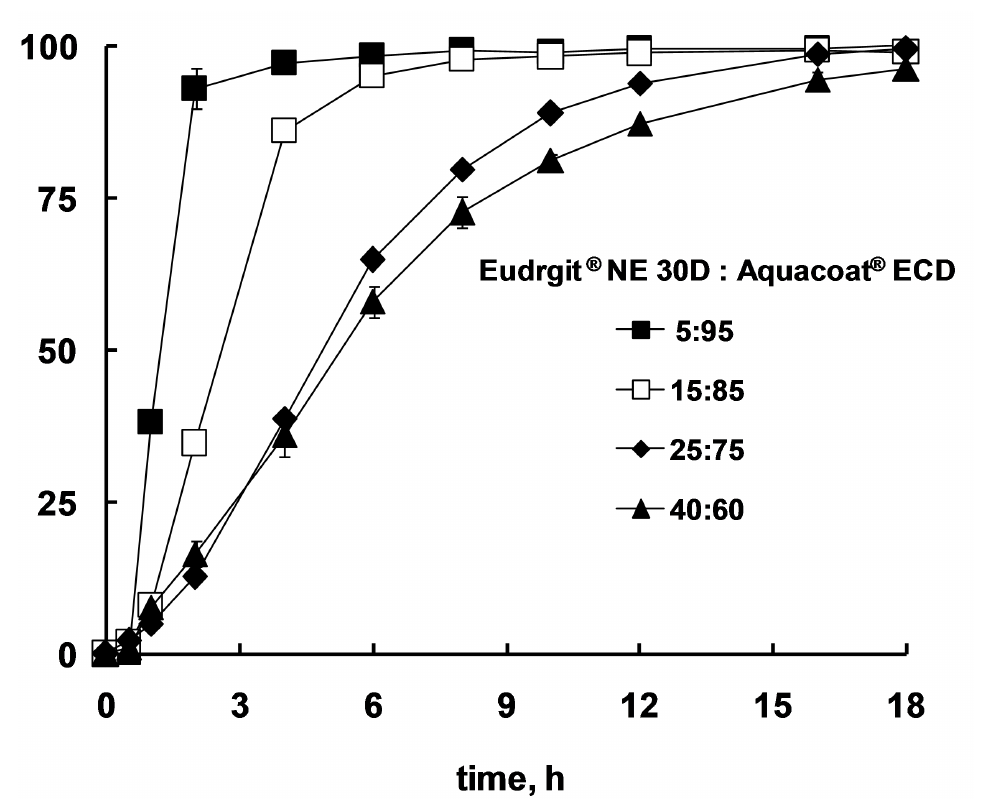
FIGURE 7 - Drug release from pellets based on sugar cores loaded with 10% propranolol HCl and coated with different polymer blend ratios of Eudragit ® NE 30D: Aquacoat ® ECD using 35% talc, coating level 20%.